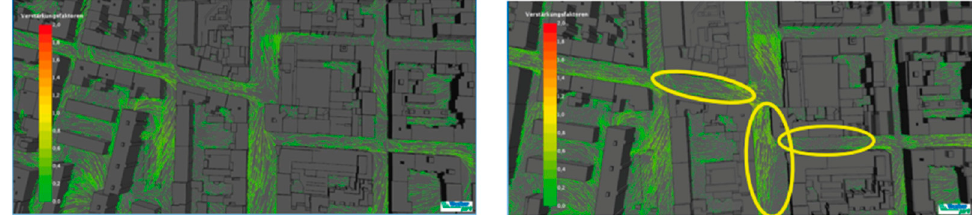
Figure 14. Changes in wind speed and direction for wind direction west for base case ( left ) and densification scenario ( right ) with streets with significant changes marked in yellow.